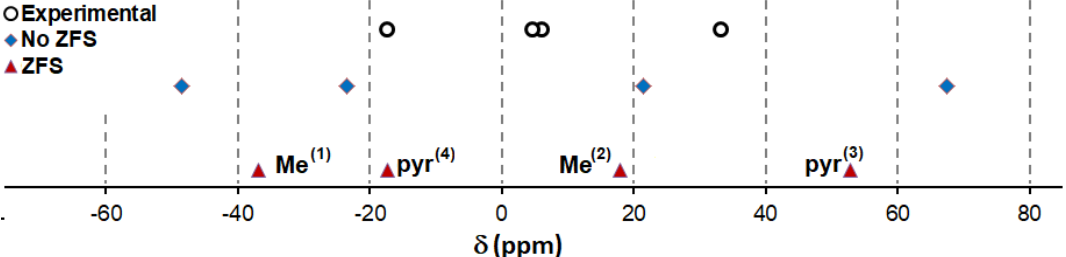
with and without ZFS at 303 K. 3 in ppm at 303K). 3